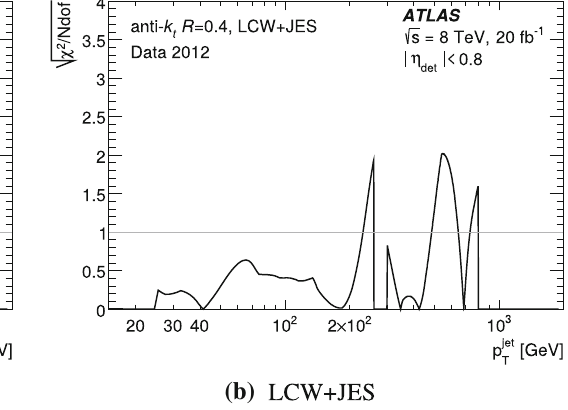
Fig. 39 χ 2 / n dof for the combination of absolute in situ measurements illustrating the compatibility of the included in situ calibrations as a function of jet p T . At any given point, there are at most two in situ results being combined: Z +jet and γ +jet at low p T , or γ +jet and MJB at high p T , which means that the number of degrees of freedom